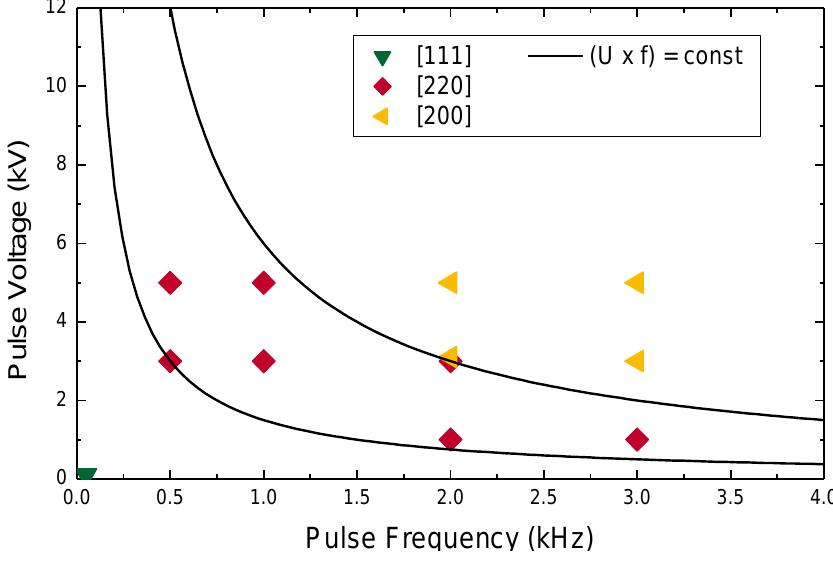
Figure 11 . Observed texture evolution as a function of pulse voltage and frequency for the formation of TiN by PIIID [101]. The data points show the measured texture for thin film produced at different voltage/frequency combinations, the thin lines show the approximate texture transitions boundaries when assuming that the average energy alone is the dominating factor to determine the